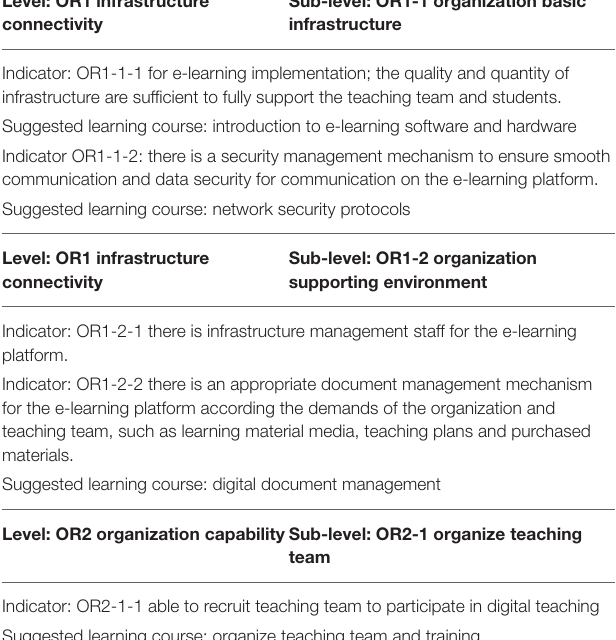
Sub-level: OR1-1 organization basic